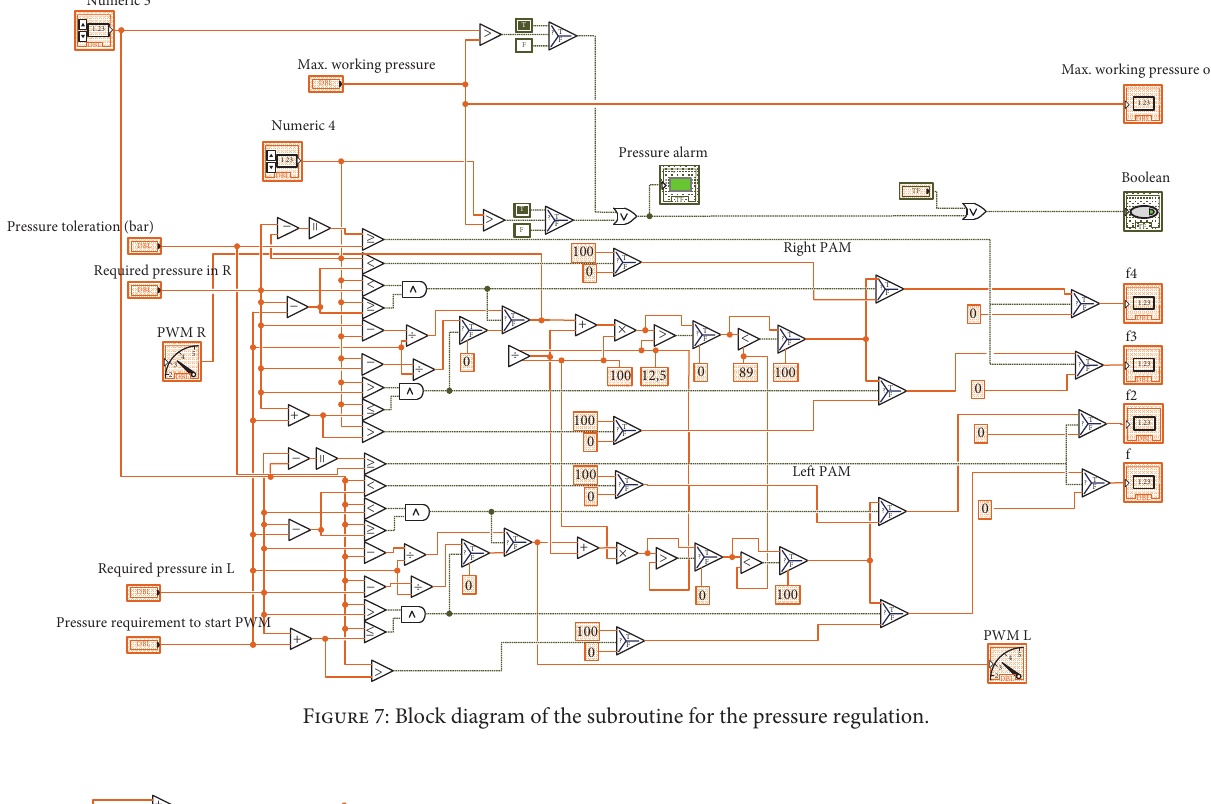
Figure 7: Block diagram of the subroutine for the pressure regulation.